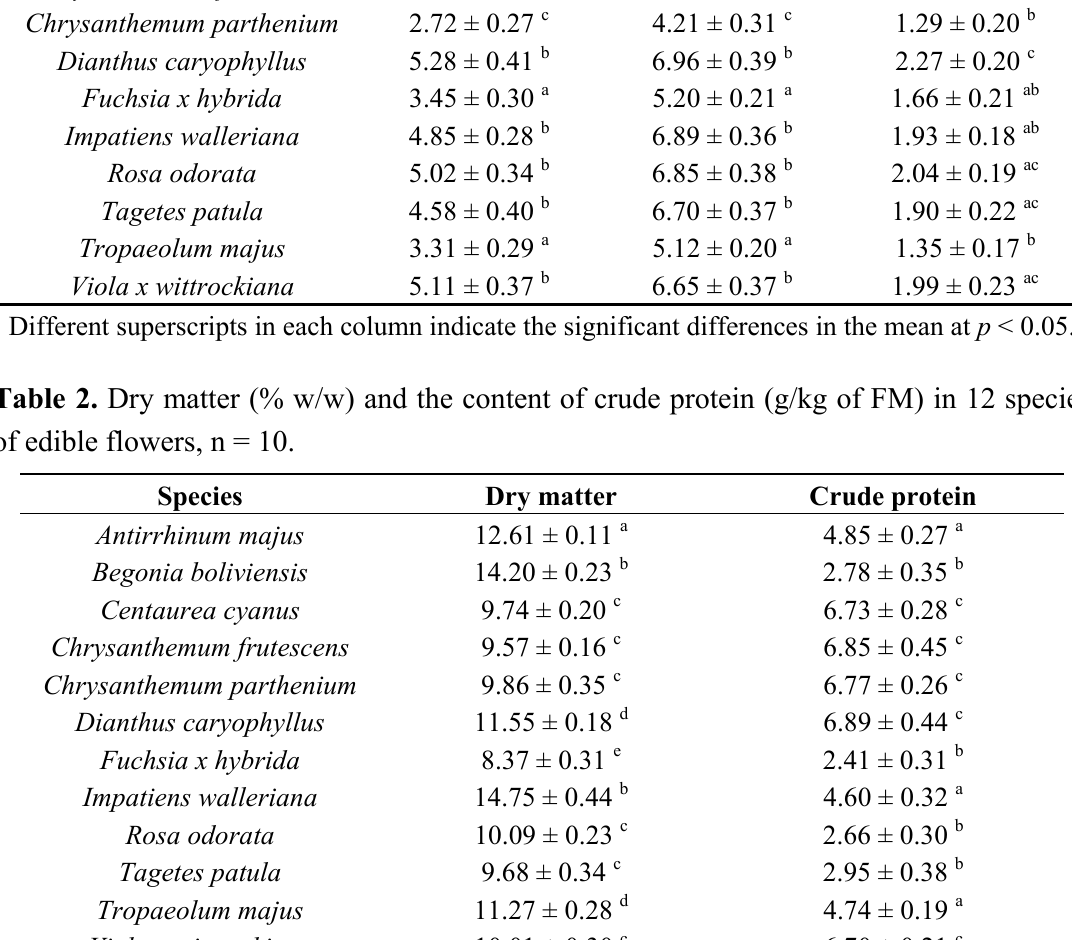
Different superscripts in each column indicate the significant differences in the mean at p <